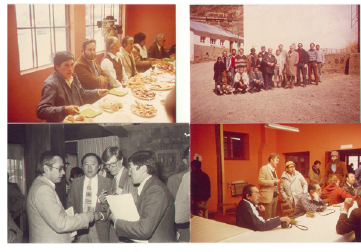
Figure 13. Worshop at LaPaz.